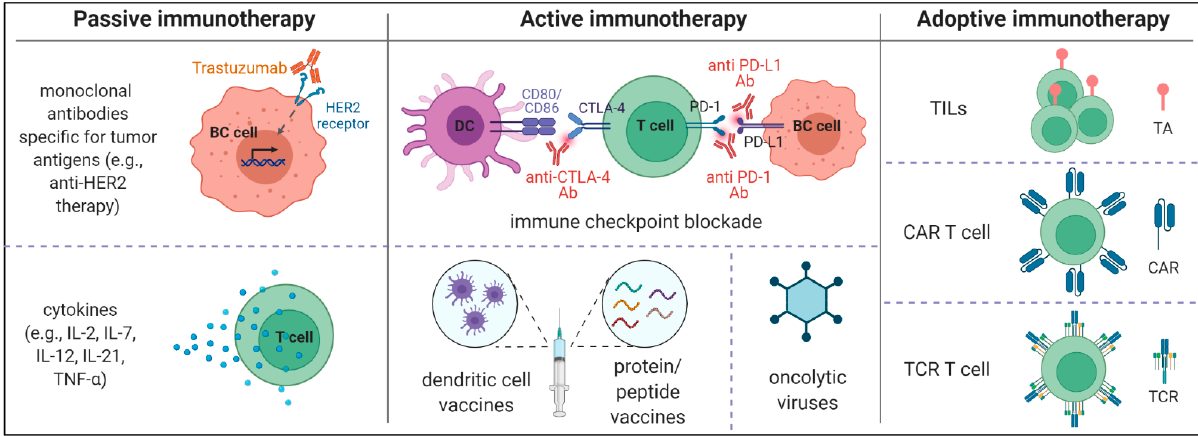
Figure 2. Immunotherapeutic strategies in breast cancer. BC cell—breast cancer cell, IL—interleukin, TNF- α —tumor necrosis factor-alpha, DC—dendritic cell, Ab—antibody, TILs—tumor-infiltrating lymphocytes, TA—tumor antigen, CAR—chimeric antigen receptor, TCR—T cell receptor. Created with BioRender.com.